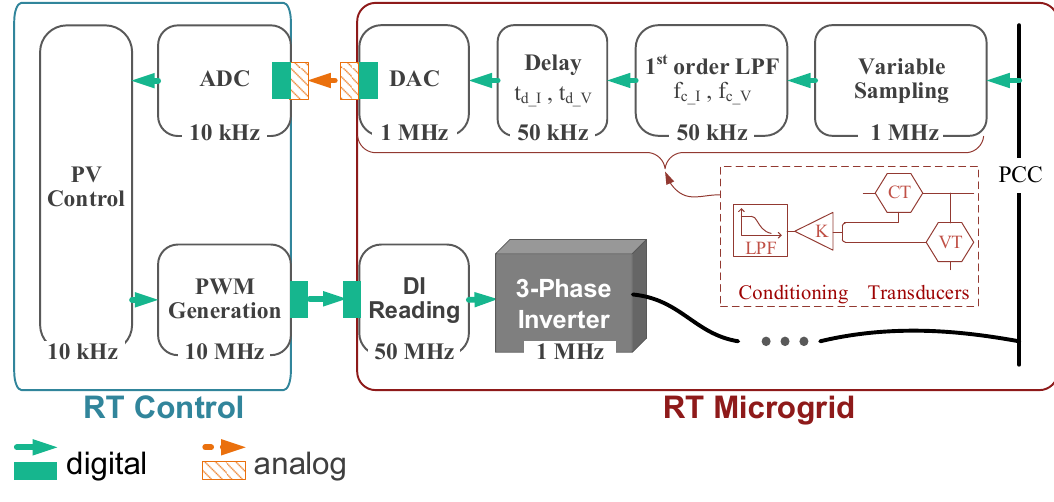
Figure 13. CHIL interfacing